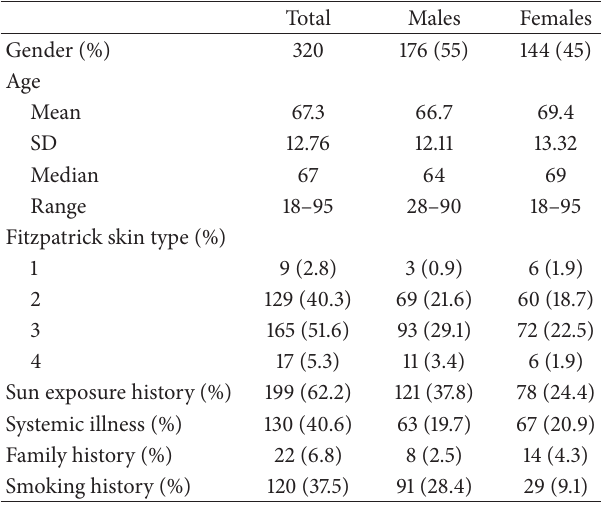
Table 1: Demographic analysis of